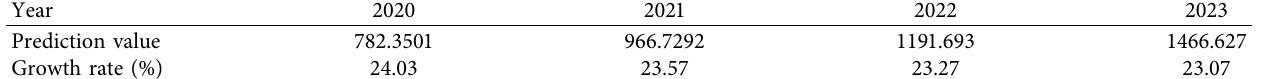
Table 2: The prediction values of China’s express business volume from 2020-2023 (100 million